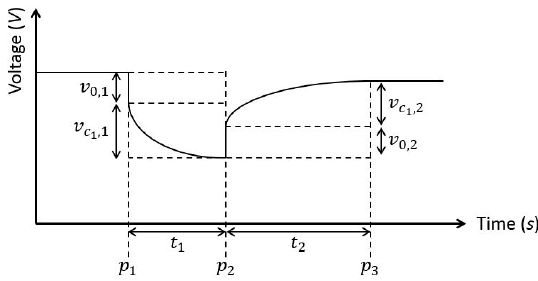
Figure 2. Impedance voltage response.